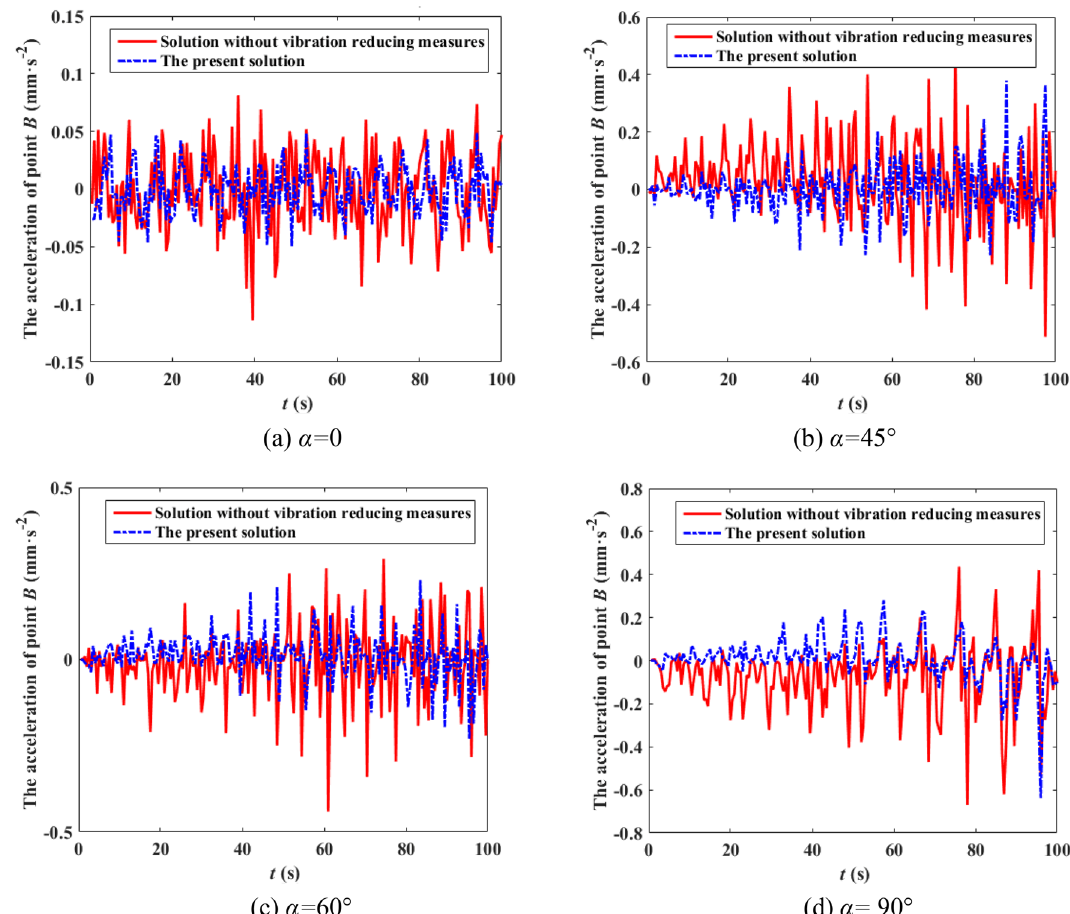
Figure 14. Acceleration time history curve of point B under different wind